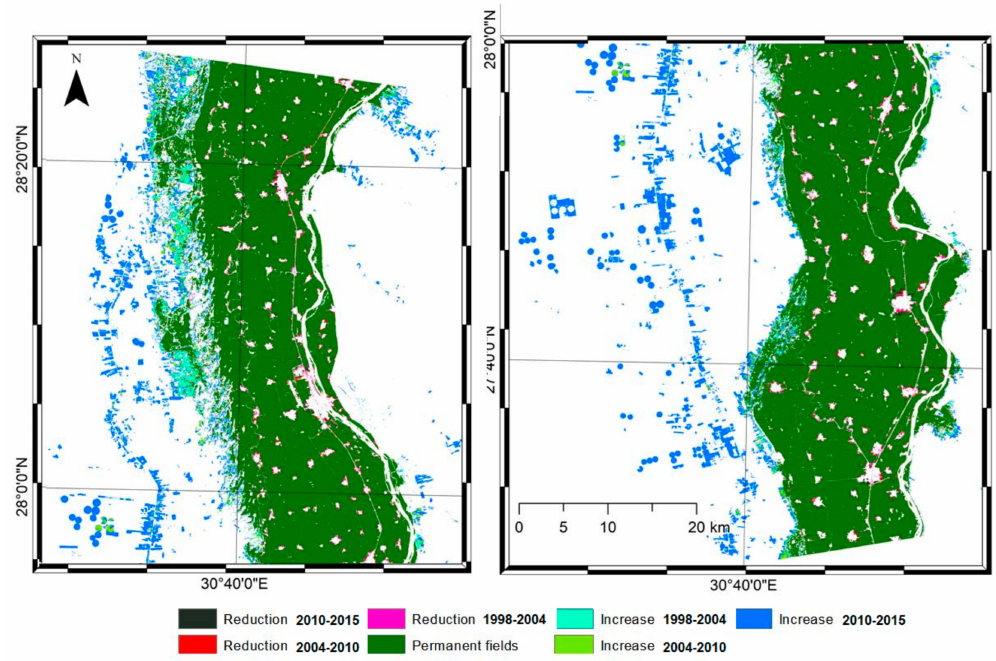
Figure 7. Changes in the spatial extent of agricultural fields for the El-Minya governorate from 1998 to 2015. Permanent fields in the edges indicate the limits of the Nile valley